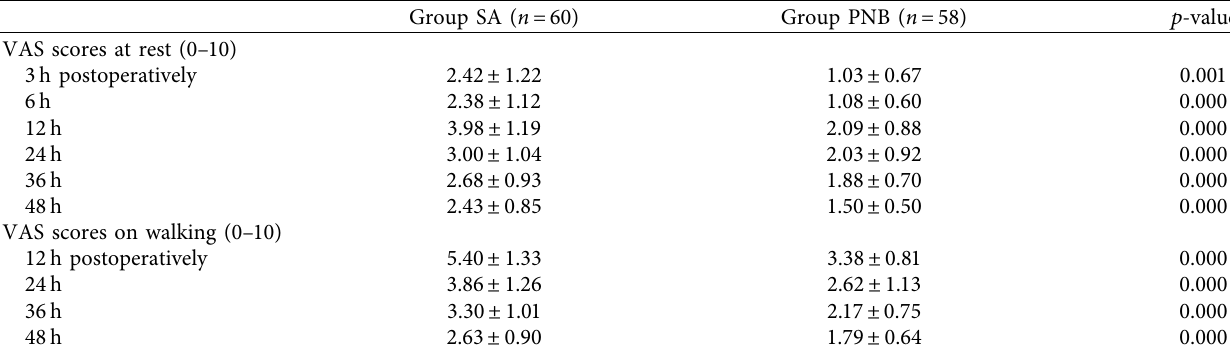
Table 2: Pain scores at 3, 6, 12, 24, 36, and 48 hours after surgery.